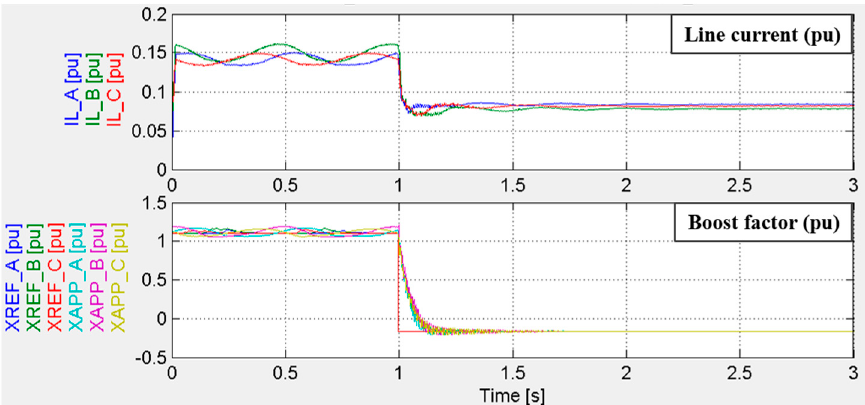
Figure 10. TCSC bypassed on site.